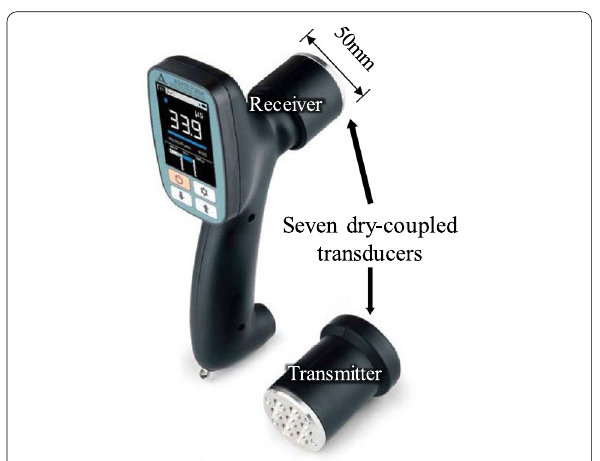
Fig. 4 Applied dry-coupled UPV transducer (ACSA A1410 Pulsar)